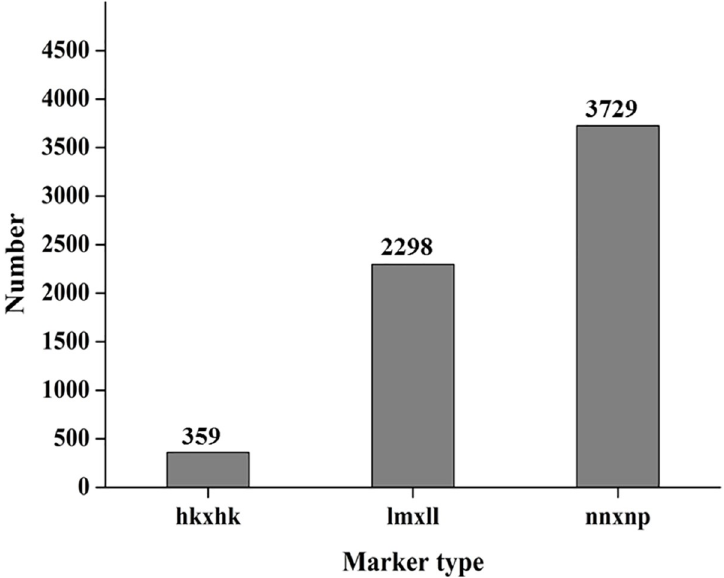
Fig 4. Number of different genotype markers. lm × ll represent the markers used for female map construction and the order was male × female, nn × np represent the markers used for male map construction and the order was female × male, hk × hk represent the markers contained by both of the parents.